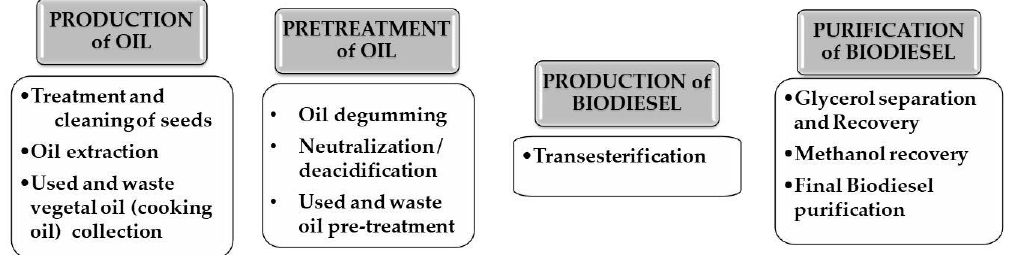
Figure 3. Overview of the biodiesel production.